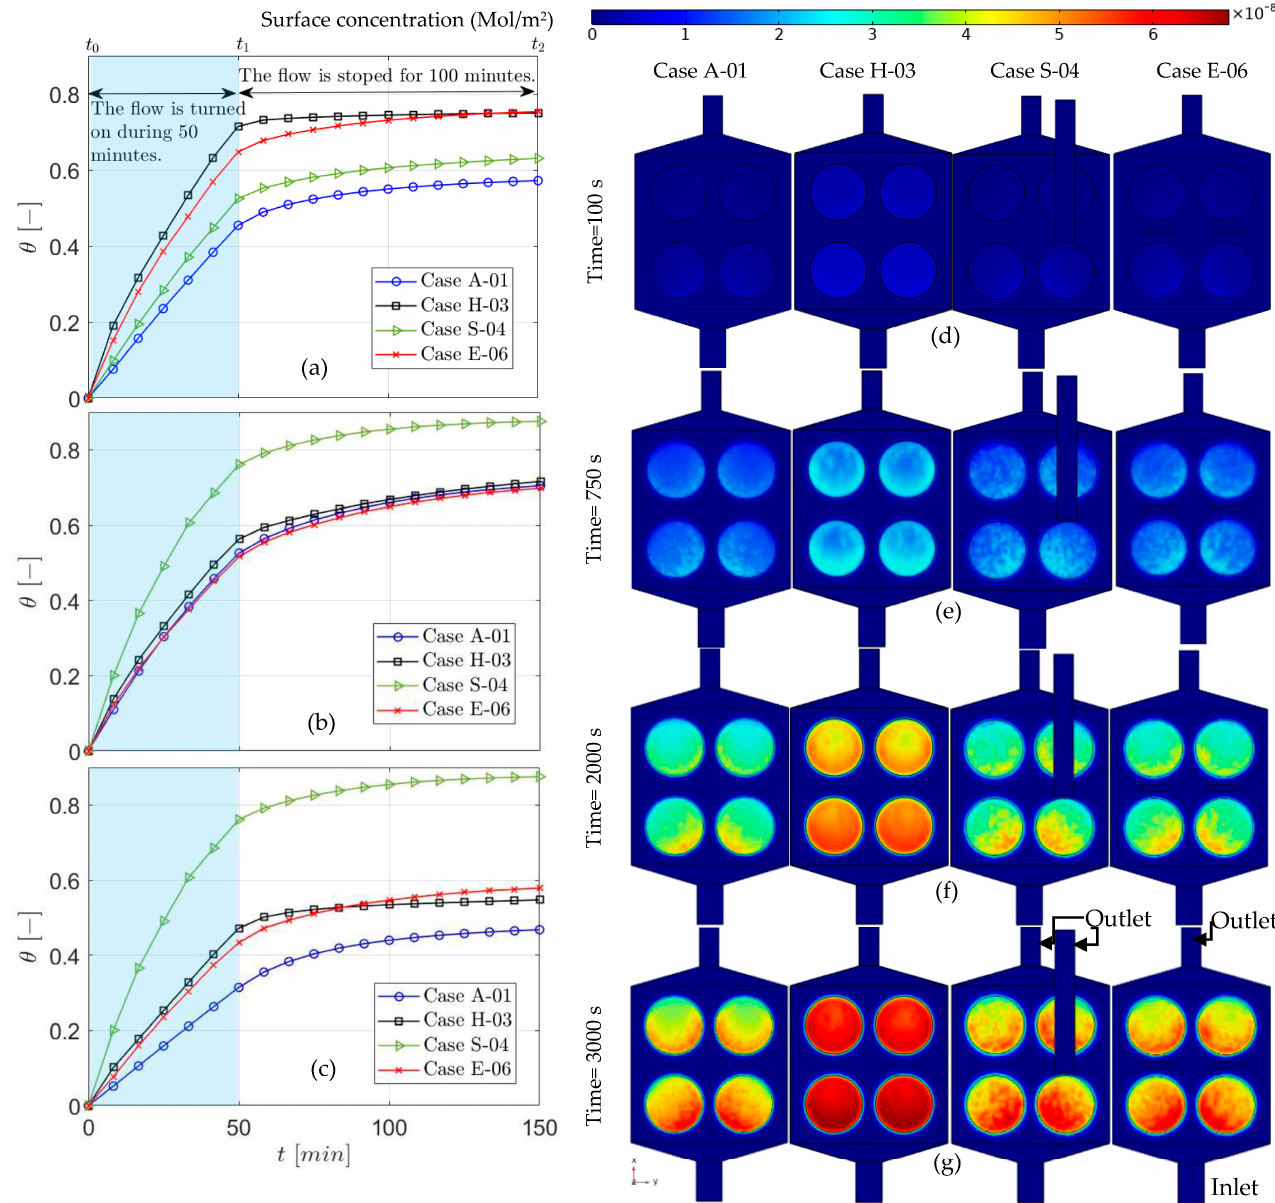
Figure 4. The time-dependent solution for surface coverage of the original experimental setup (Case A) in comparison to cases H-03, S-04, and E06 for the whole surface ( a ), Pt f ( b ) and Pt b ( c ). A slide of surface concentration contour on the functionalized surfaces for cases A-01, H-03, S-04, and E06, after 100 s ( d ), 750 s ( e ), 2000 s ( f ) and 3000 s ( g ).